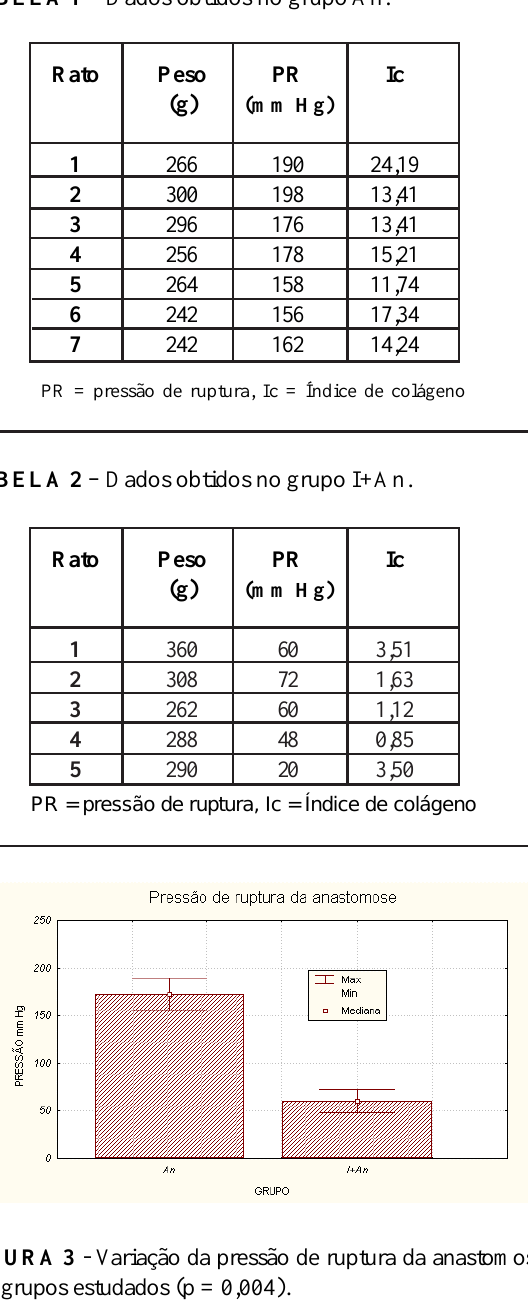
TABELA 1 – Dados obtidos no grupo